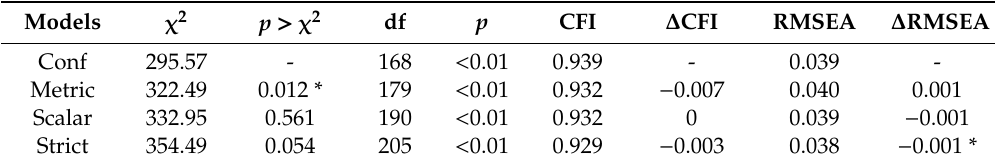
Table 4. Fit indexes for the invariance 4-D R model.